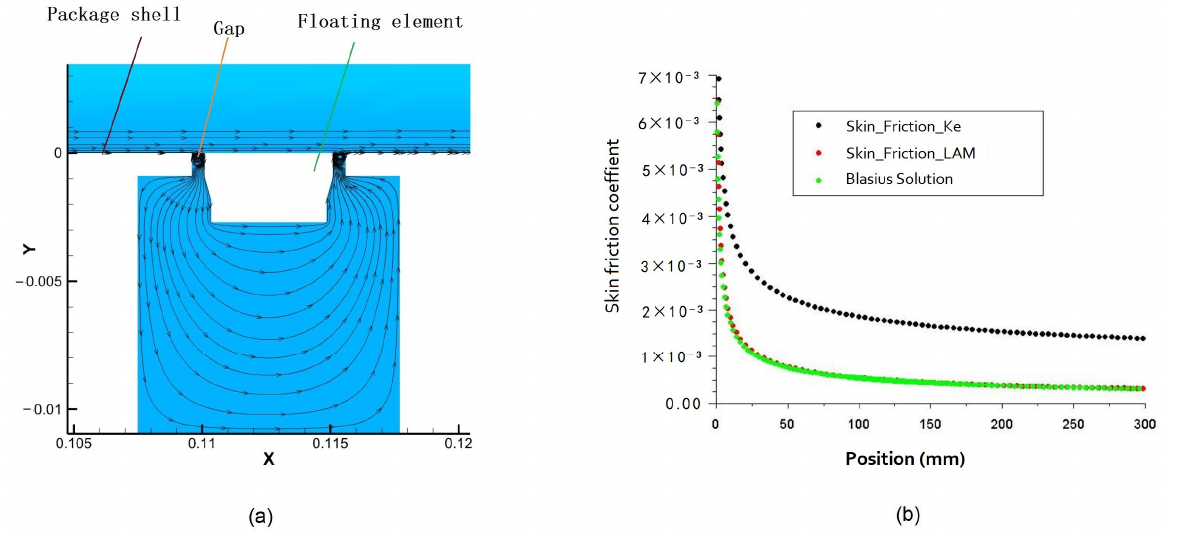
Figure 2. ( a ) The 2D streamline diagram in the friction sensor; ( b ) the skin friction coefficient of the flat plate in the laminar flow model and turbulent model under a total pressure of 1.5 MPa incoming flows.